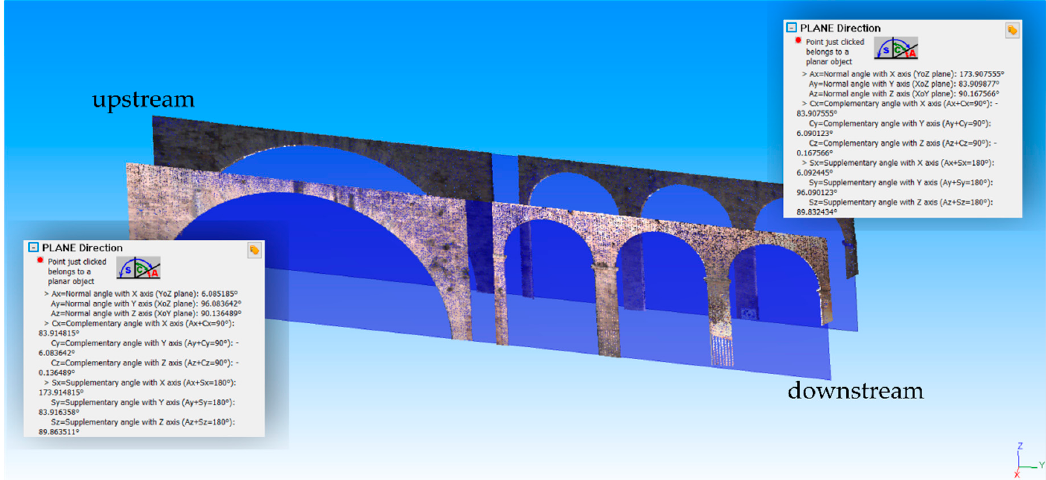
Figure 13. Best-fitted upstream plane and best-fitted downstream plane. Attached boxes gives information about each plane direction.